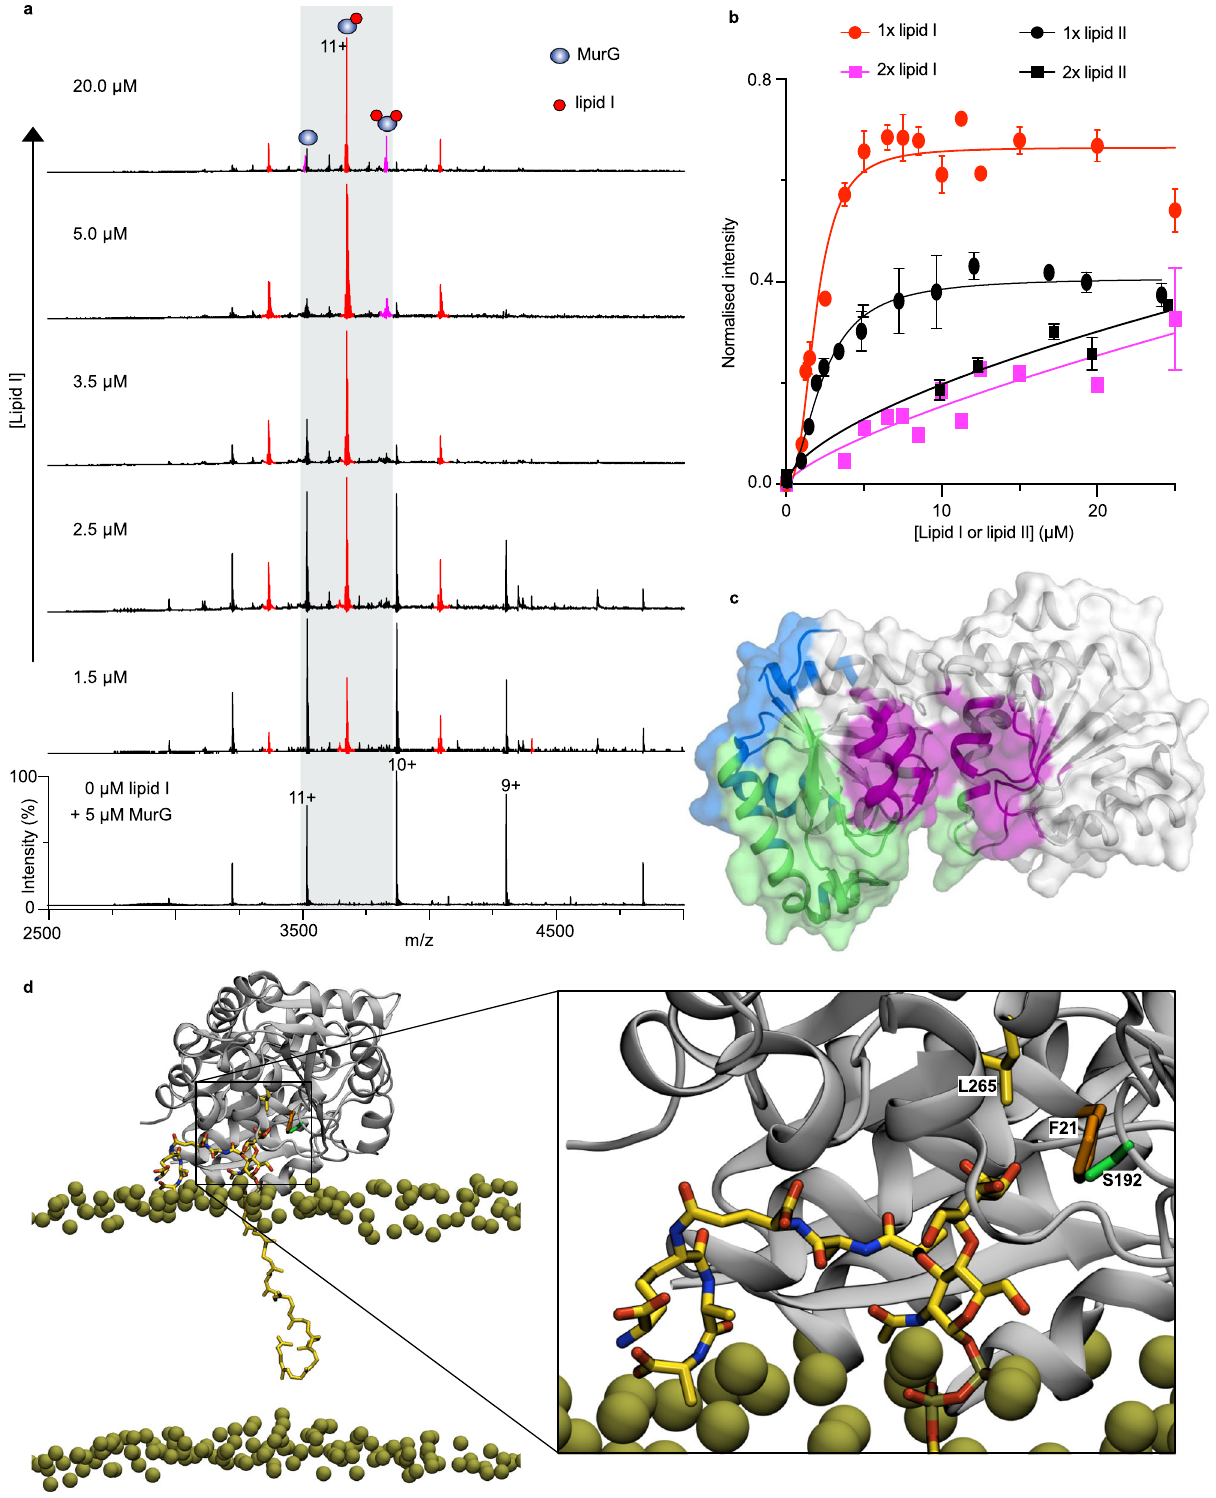
series corresponding to monomers (Fig. 4a). To investigate the af fi nity of MurG for its native substrate lipid I, we recorded spectra for solutions containing 5 µM MurG and 0 – 25 µM lipid I (Fig. 4a). At lipid I concentration of 1.5 µM, charge state series were observed with an additional mass of 1717 Da, consistent with one molecule of lipid I bound to MurG. Further increase in lipid I concentration yielded additional charge state series